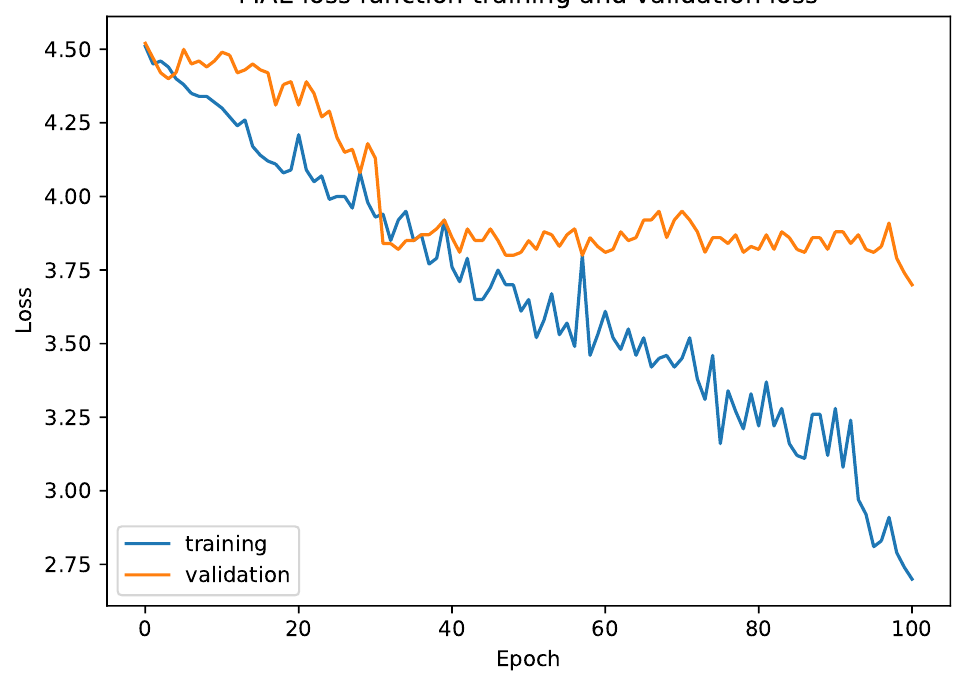
Figure 6. Mean absolute error (MAE) loss function for training and validation.